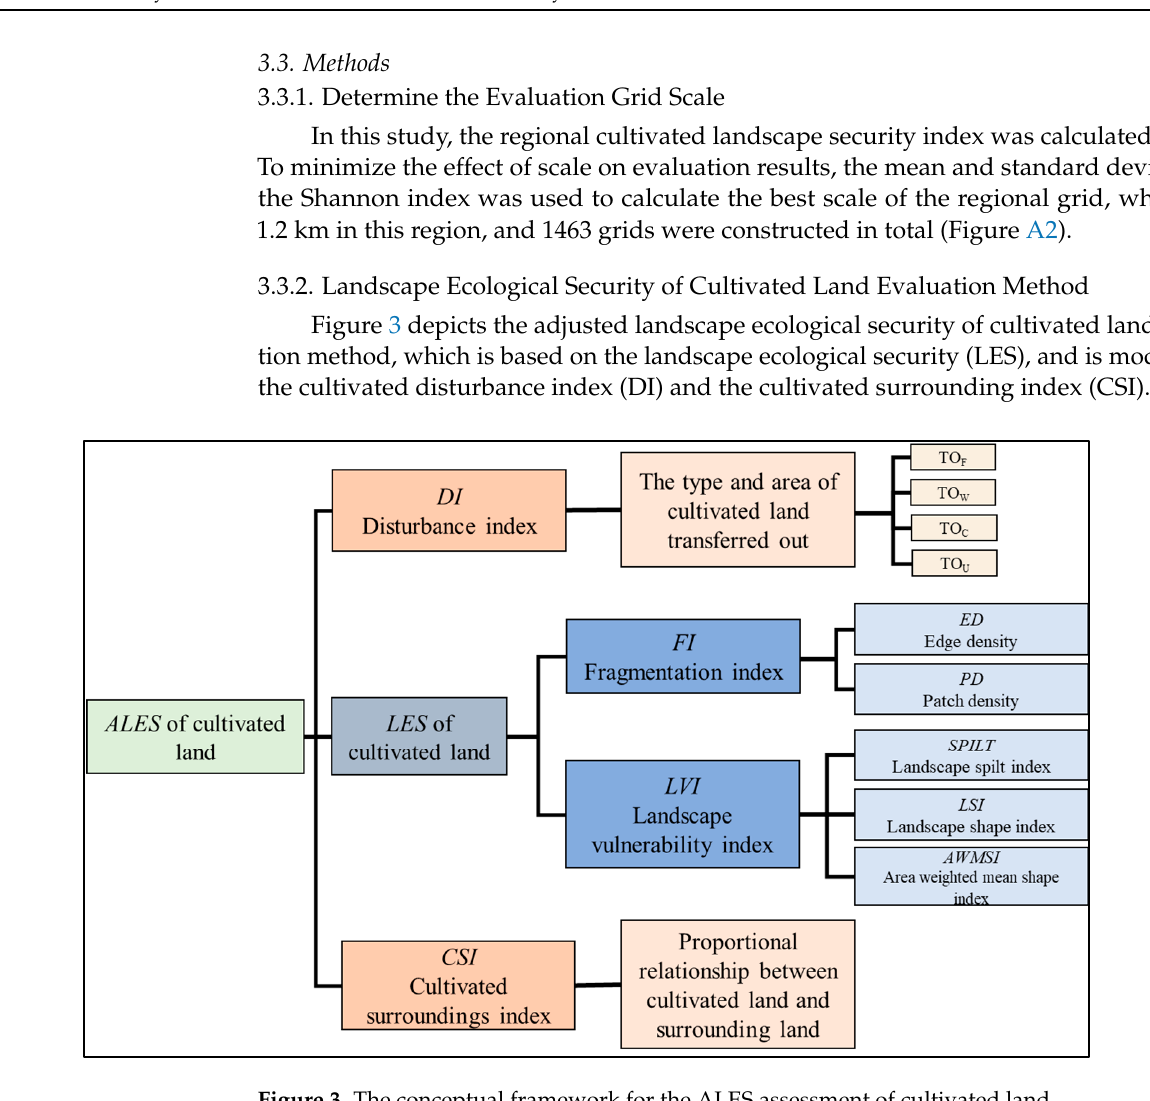
Figure 3. The conceptual framework for the ALES assessment of cultivated land.